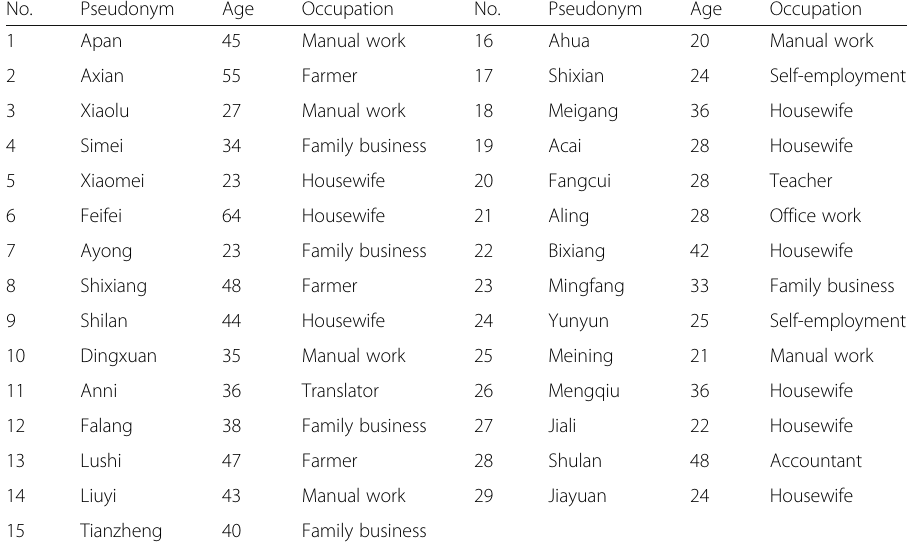
Table 1 Profile of the research participants ’ occupational backgrounds